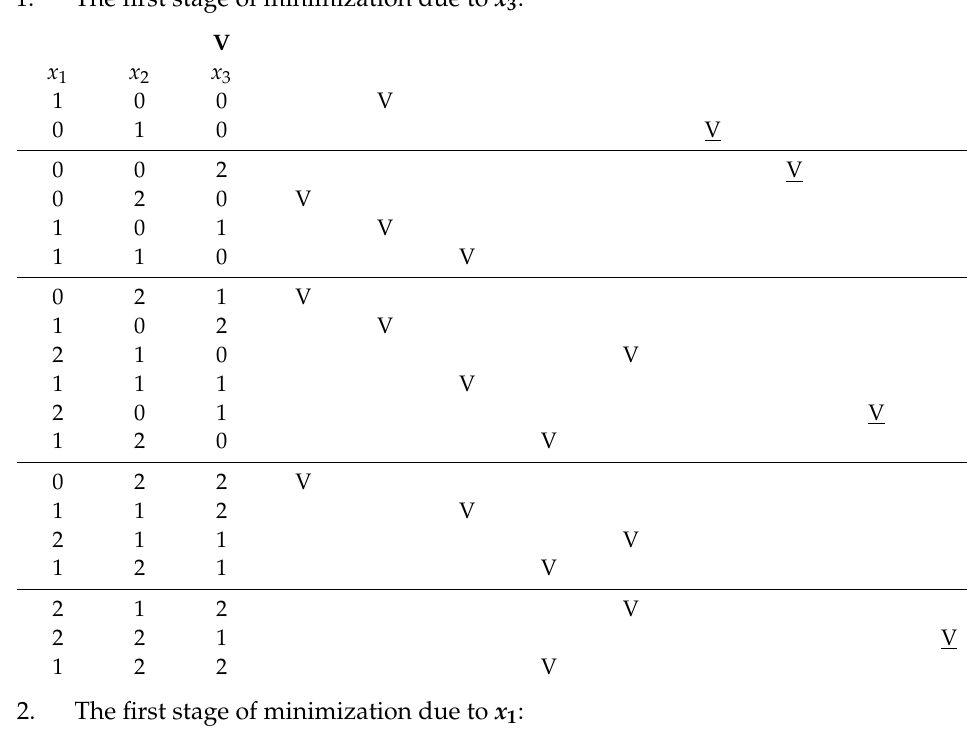
Figure 6. ZKAPN and MZAPN of the given logical function from Example 2. 1.